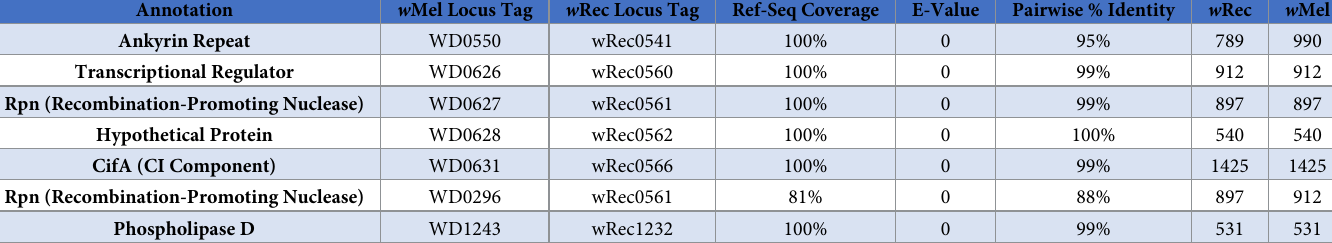
Table 1. Comparative genomic analysis of male-killing gene candidates. After applying all criteria in the genomic analysis, seven candidates for male killing were iden- tified. All seven gene candidates are listed with their functional annotation and locus tags from both w Mel and the closely related w Rec strain. BLASTP results of the homo- logs are also shown with the percent coverage, E-value, pairwise identity, and number of nucleotides for each strain. For inclusion and exclusion criteria, see S1 Table. WD0626 from w Mel is the gene hereafter denoted WO-mediated killing or wmk